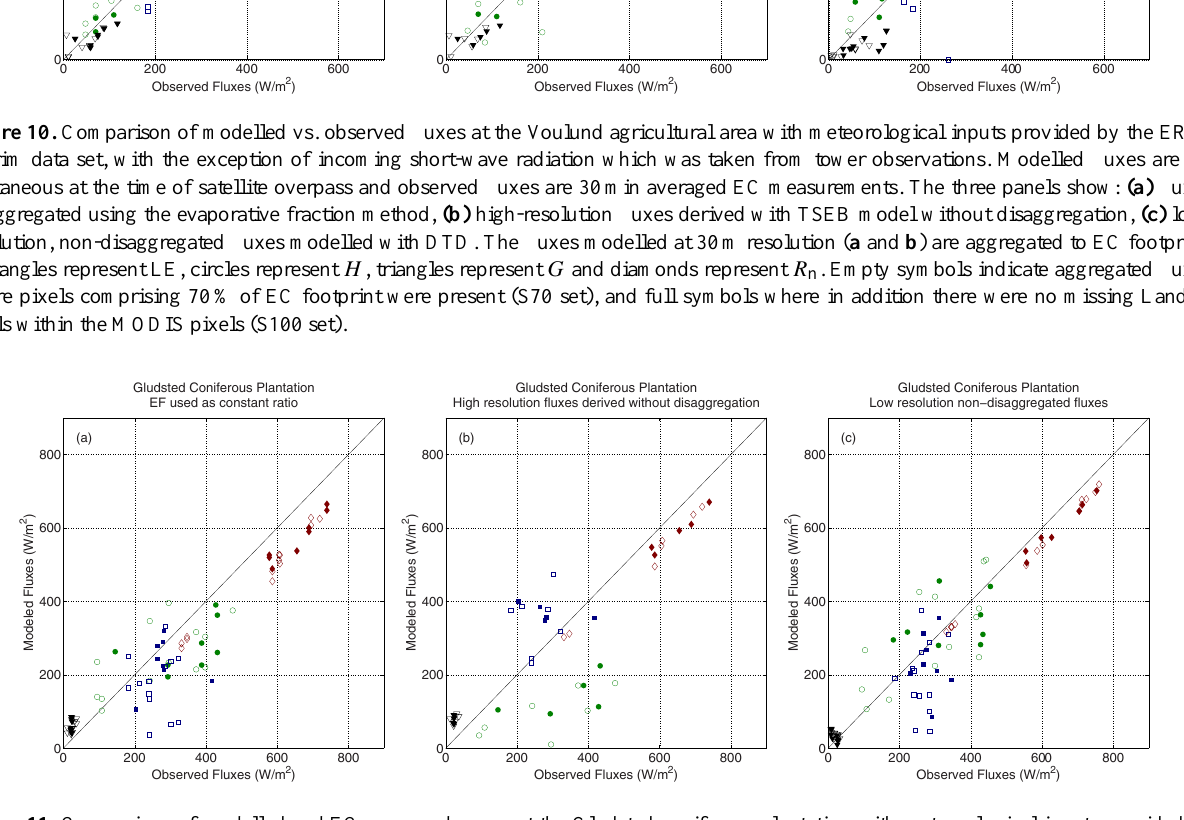
Figure 11. Comparison of modelled and EC measured fluxes at the Gludsted coniferous plantation with meteorological inputs provided by the ERA-Interim data set, with the exception of incoming short-wave radiation which was taken from tower observations. Modelled fluxes are instantaneous at the time of satellite overpass and observed fluxes are 30min averaged EC measurements. The three panels show: (a) fluxes disaggregated using the evaporative fraction method, (b) high-resolution fluxes derived with TSEB model without disaggregation, (c) low-resolution, non-disaggregated fluxes modelled with DTD. The fluxes modelled at 30m resolution (panels (a) and (b) ) are aggregated to EC footprint. Rectangles represent LE, circles represent H , triangles represent G and diamonds represent R n . Empty symbols indicate aggregated fluxes where pixels comprising 70% of EC footprint were present (S70 set), and full symbols where in addition there were no missing Landsat pixels within the MODIS pixels (S100